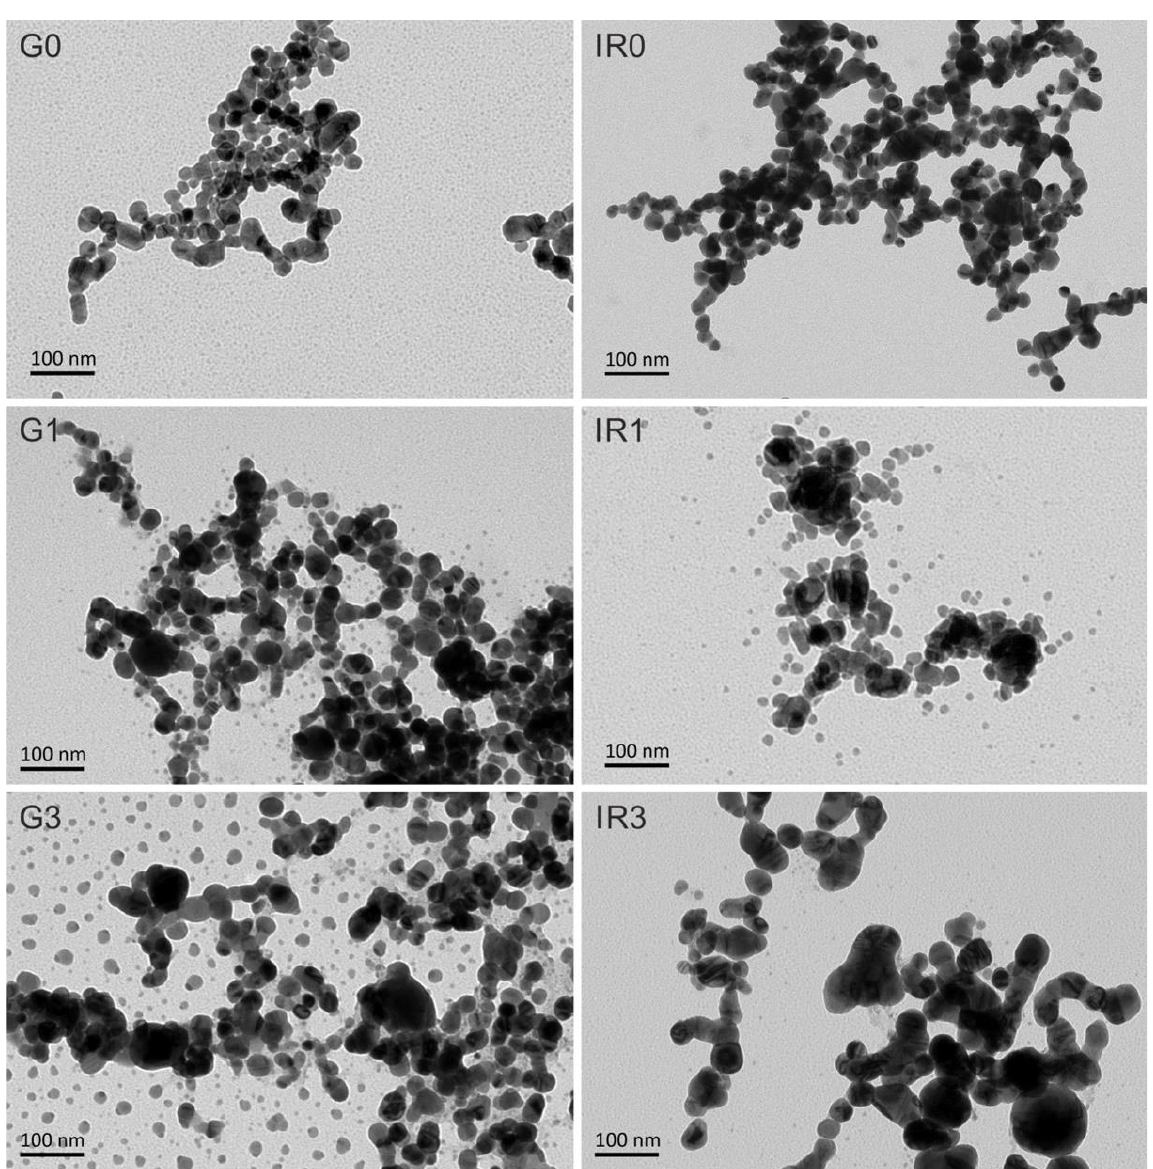
Figure 2. TEM micrographs of Ag nanoparticles obtained in water: ( G0 ) by laser ablation with Green-nanosecond laser, ( IR0 ) by laser ablation with IR-picosecond laser, ( G1 ) after one re-irradiation with Green-nanosecond laser, ( IR1 ) after one re-irradiation with IR-picosecond laser, ( G3 ) after three re-irradiations with Green-nanosecond laser, and ( IR3 ) after three re-irradiations with IR-picosecond